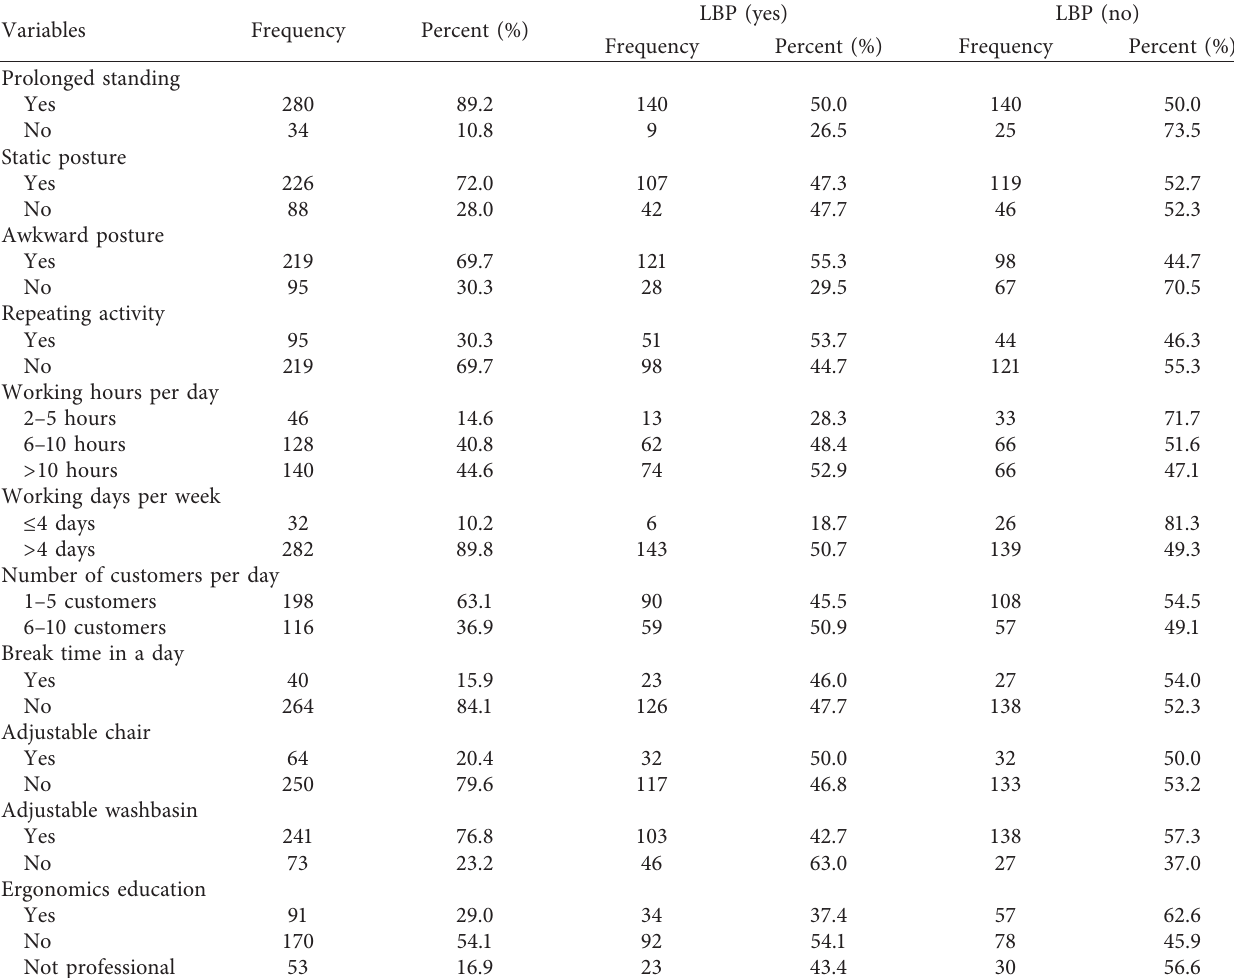
Table 2: Working environment, ergonomic characteristics, and prevalence of LBP among the study participants, April 2018 ( n � 314). Variables